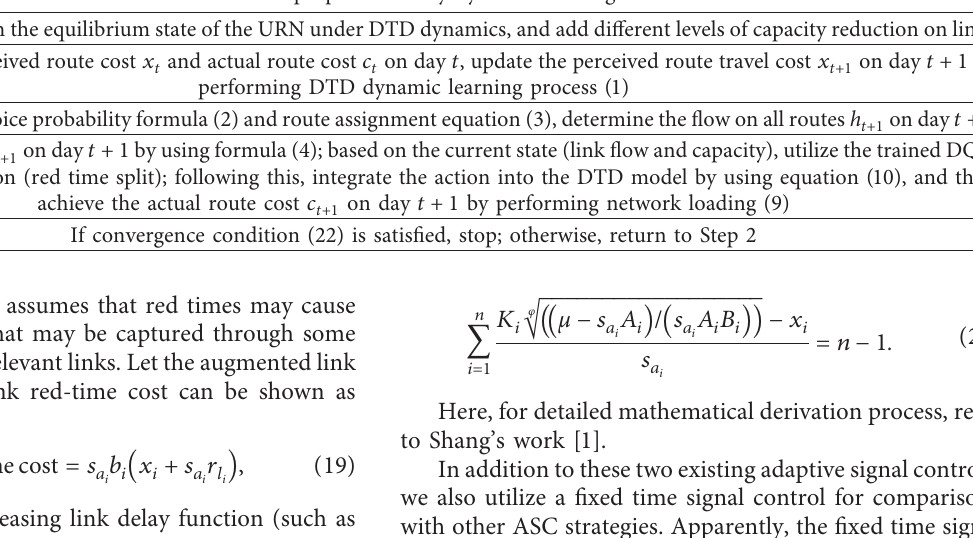
Table 2: Procedures for the proposed doubly dynamic learning